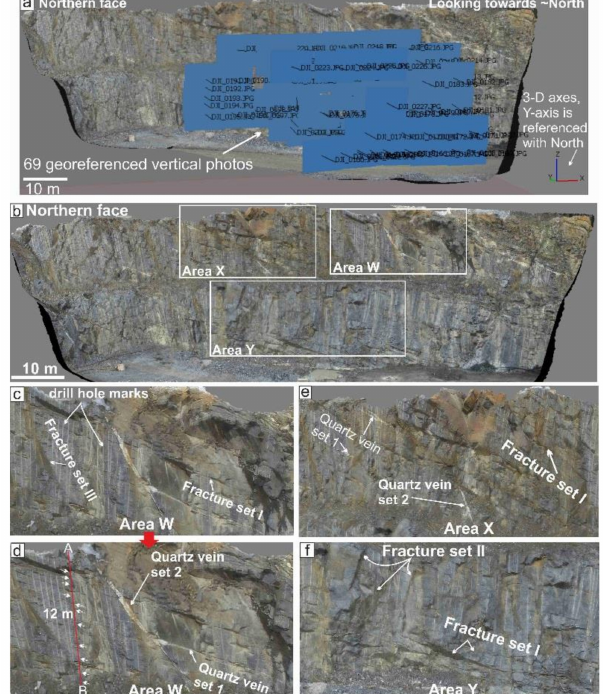
Figure 4. ( a ) High-resolution (1.4 cm/pixel) textured photogrammetric 3-D model of selected portions of the northern face (see Figure 3c for location). 69 georeferenced images were taken using the Phantom 3 Professional with the camera axis kept horizontal. ( b ) Three representative areas outlined with rectangular boxes (W, X, Y) where ‘virtual’ structural measurements were collected. ( c , d ) Close ups of area W viewed from different angles showing fracture set I and III and associated quartz veins 1 and